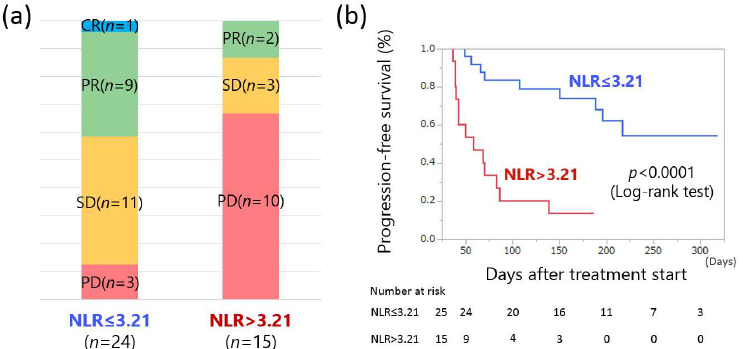
Figure 5. ( a ) Comparison of response to atezolizumab + bevacizumab combination therapy in pre- treatment low neutrophil-to-lymphocyte ratio (NLR) and high NLR groups (CR, complete